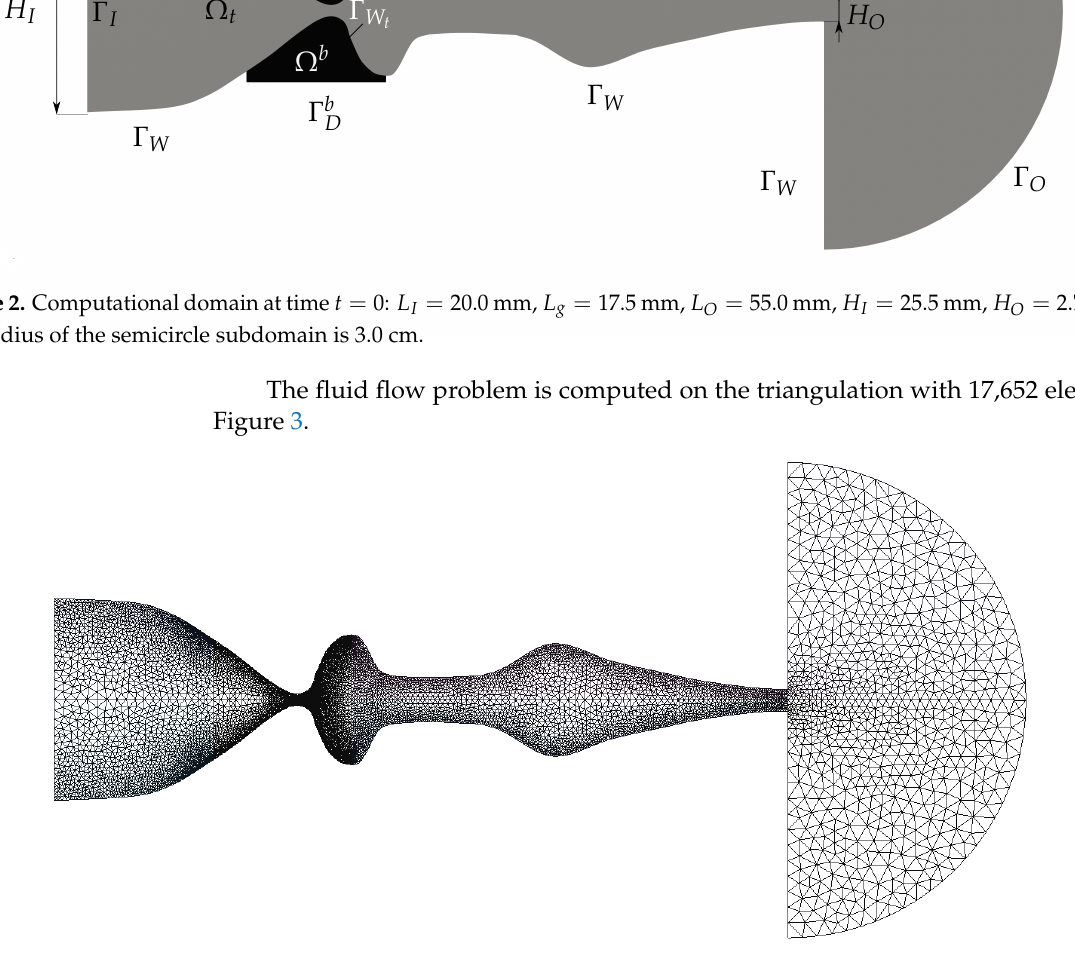
Figure 3. Triangulation of the fluid